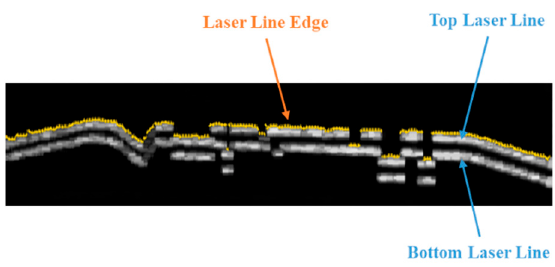
Figure 11. Extraction of top laser line on the acquired image of the contact